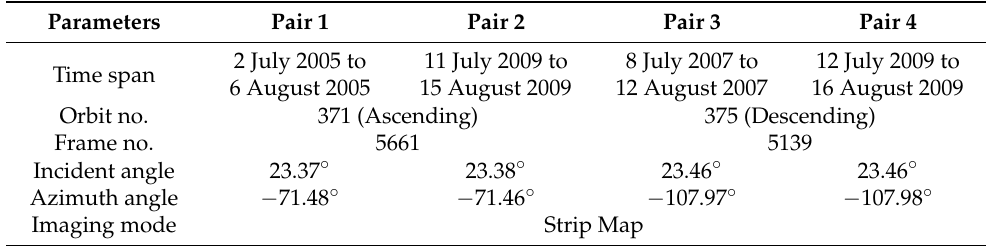
Table 1. Basic information for the ENVISAT ASAR interferometric pairs used herein. Parameters Pair 1 Pair 2 Pair 3 Pair 4 Time